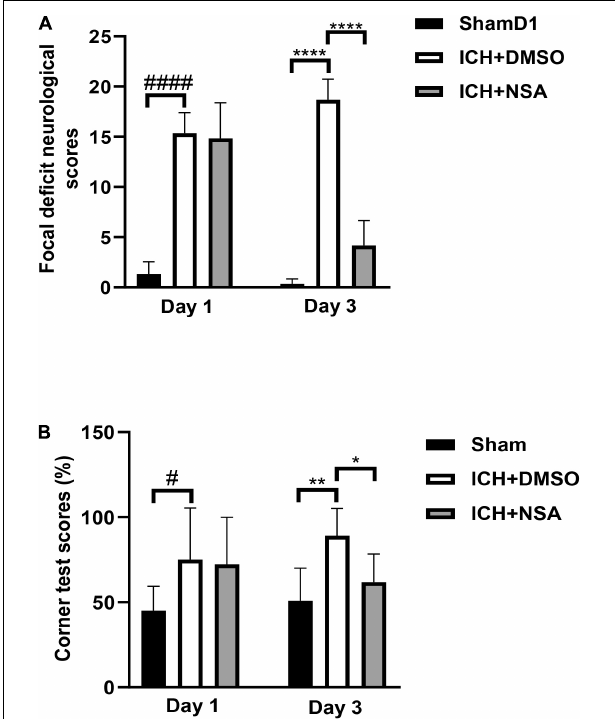
FIGURE 6 | Necrosulfonamide (NSA) improved neurological functions after intracerebral hemorrhage (ICH). (A) Quantification of focal neurological deficit at 3 days after ICH ( n = 6, per group). (B) Quantification of corner test scores at 1 day and 3 days after ICH ( n = 11, per group). Data are shown as mean ± SD, * p < 0.05, ** p < 0.01, **** p < 0.0001, # p < 0.05, #### p <